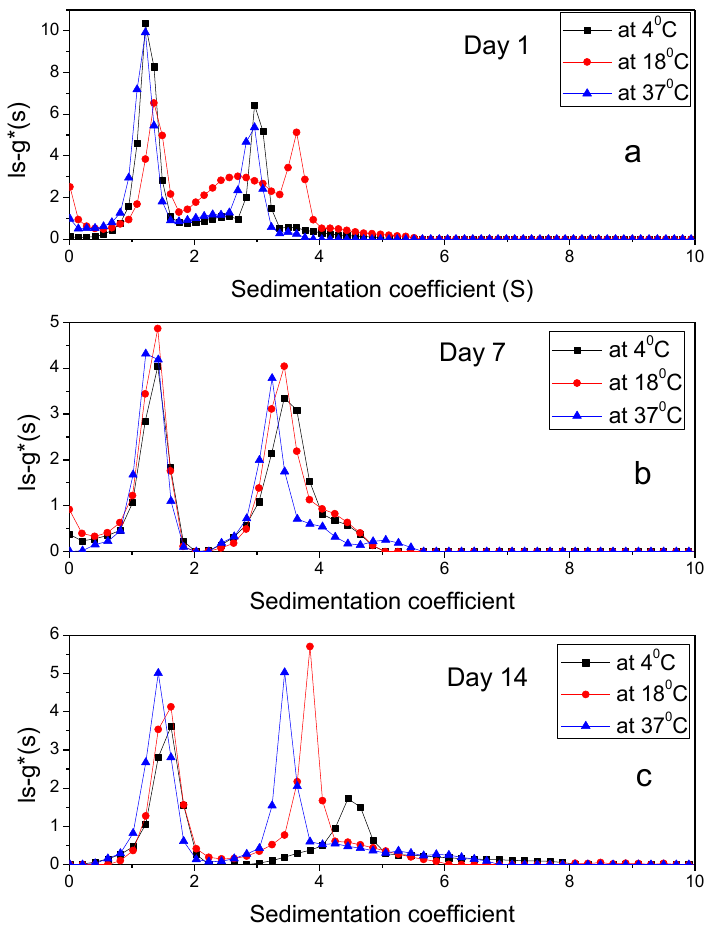
Figure 5. The sedimentation coefficient profile, ls-g*(s) for PIC ( a ) Day 1 ( b ) Day 7 ( c ) Day 14 using 50 mM PBS, pH 7.0 at 1 mg/mL loading concentration and at 4 °C, 18 °C, 37